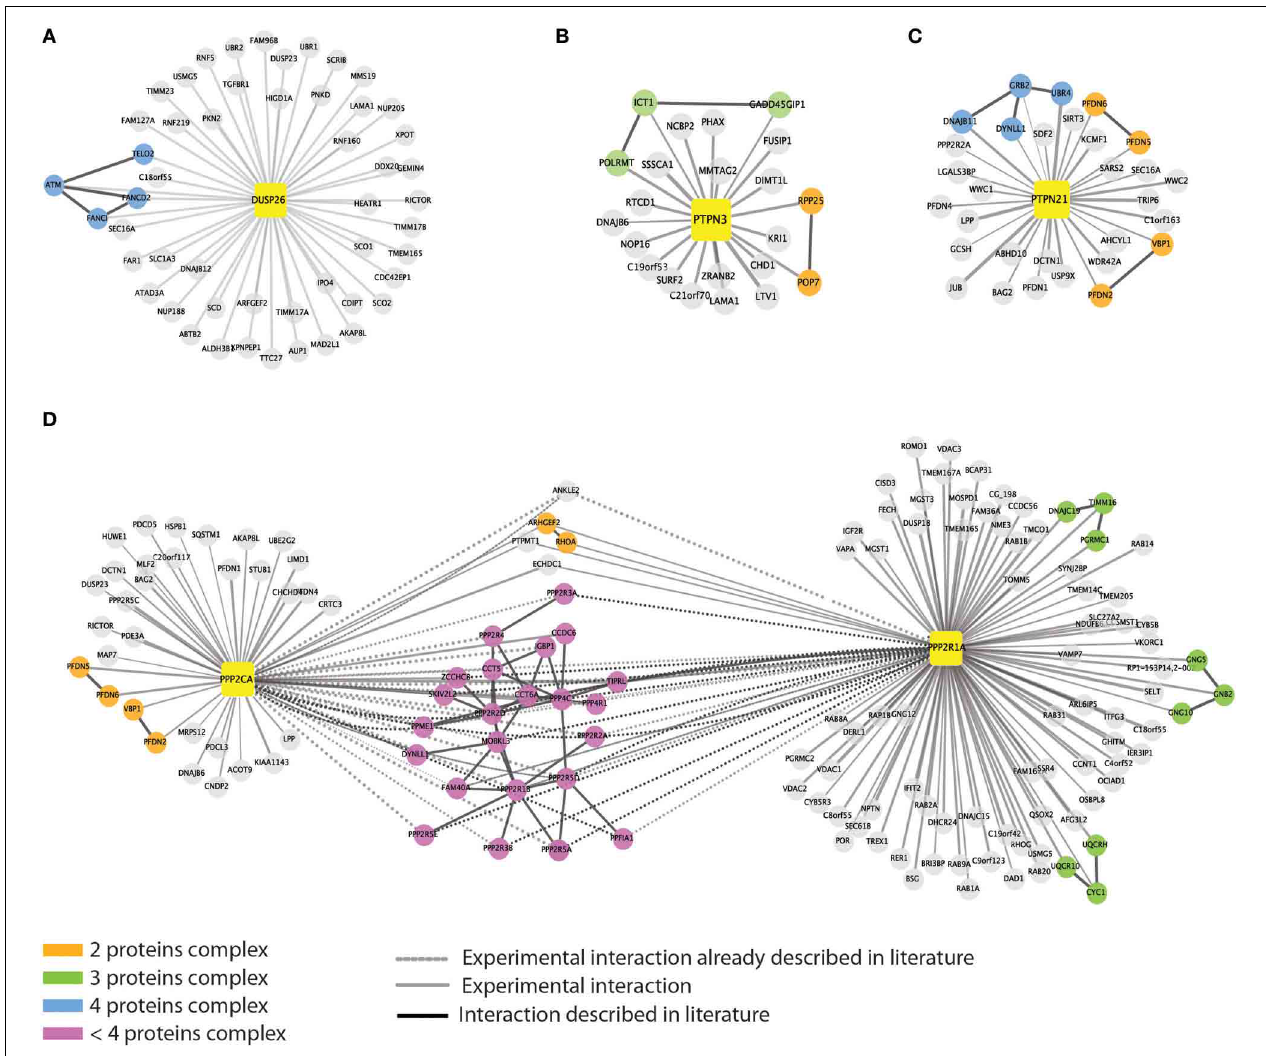
FIGURE 4 | Evidence for detection of multi-protein complexes. We queried the mentha protein interaction database to look for direct interactions among the phosphatase interactors. For five out of the eight baits we were able to retrieve information on direct interactions between the affinity purified interactors. Phosphatases are represented as yellow squares. DUSP26 (A) , PTPN3 (B) , PTPN21 (C) , and PPP2CA (D) are linked